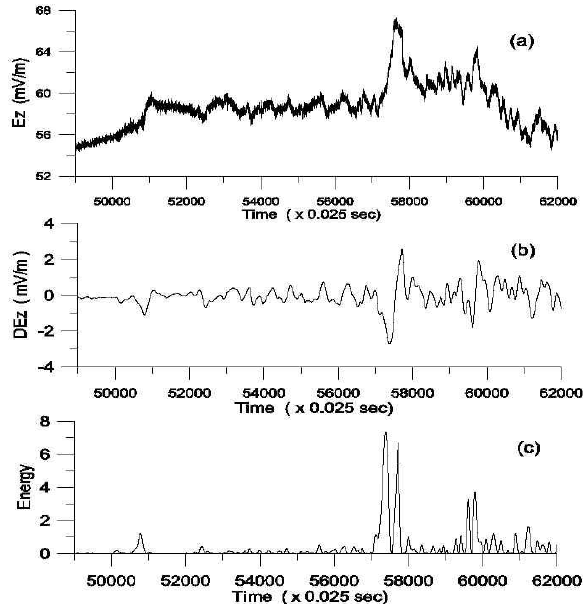
Fig. 3. (a) The perturbed waveform (shown in Fig. 2a) focussed on a time period between 49000–62000 (x 0.025s). (b) The filtered, focused, perturbed signal (Fig. 3a). For filtering we used Singular 3a). For filtering we used Singular Spectrum Analysis, combined with a third-degree polynomial filter. c) Τhe square power of pre-Earthquake signal shown in Fig. 3b. Spectrum Analysis, combined with a third-degree polynomial filter. (c) The square power of the pre-Earthquake signal shown in Fig.